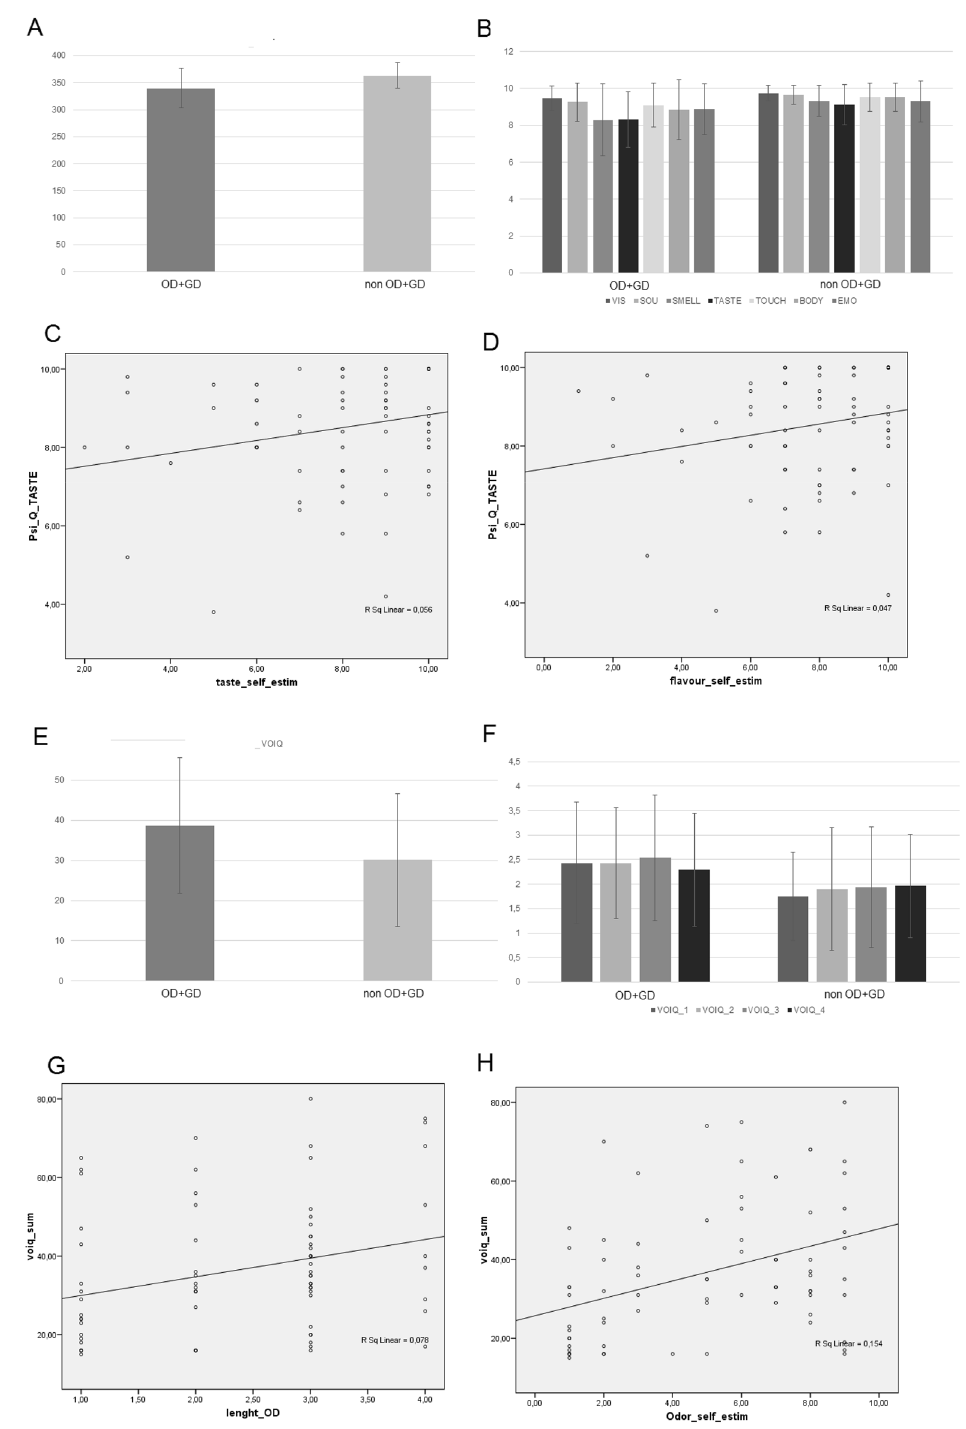
Figure 2. Patients’ performance at the Psi-Q sum of score ( A ), Psi-Q subtests ( B ), scale 0–10, poor-excellent, and correlation results ( C , D ). OD + GD = patients with odor and gustatory dysfunction. Patients’ performance at the VOIQ total score ( E ), VOIQ subtests ( F ), scale 1–5, excellent-poor, and correlation results ( G , H ). OD + GD = patients with odor/gustatory